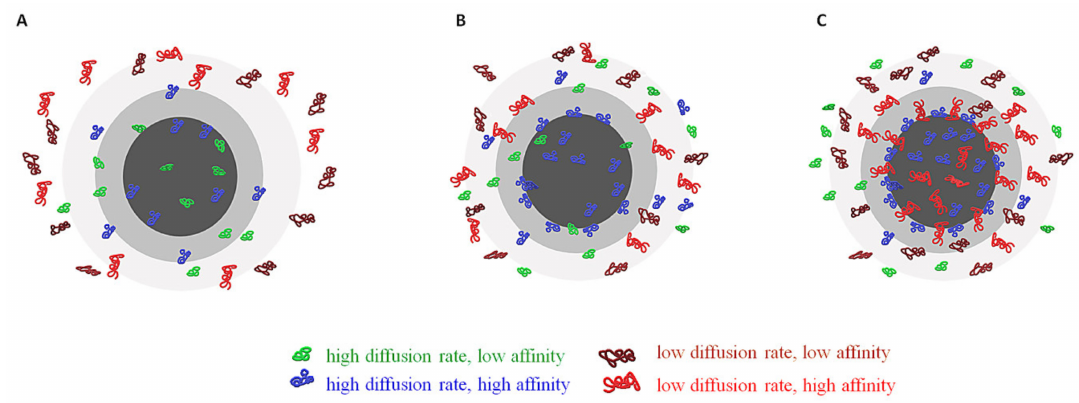
Figure 2. ( A ) Initiation of formation of PC (seconds after the NP reaches the biological fluid); ( B ) Beginning of exchange from the PC of proteins with low a ffi nity with proteins that have higher a ffi nity (seconds to minutes); ( C ) stabilized PC, with proteins with high a ffi nity occupying the first layer of PC (hard PC) and the majority of the second layer (soft PC) where proteins with low a ffi nity are still